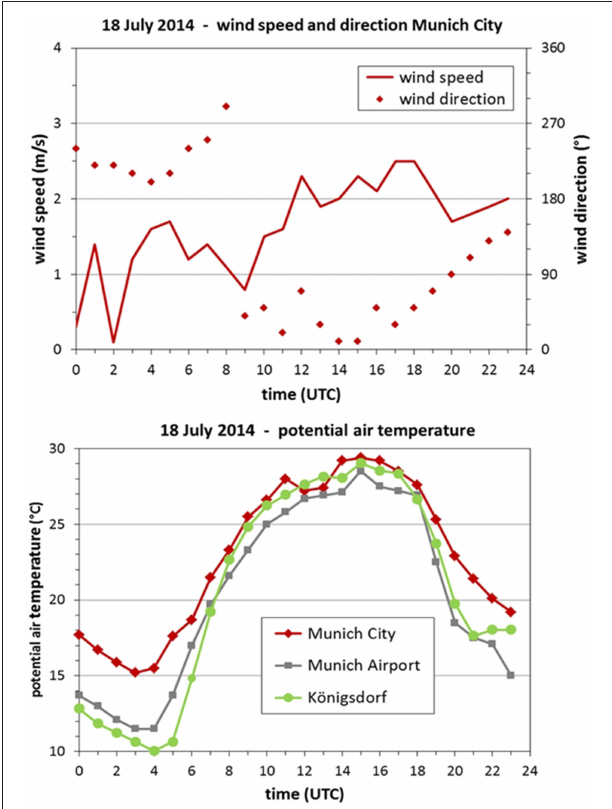
FIGURE 2 | Surface station data measured on 18 July 2014. Wind speed and direction above roof level at the station Munich City located northwest of the historic downtown area (top) and potential air temperature 2m above ground level at Munich City and at the two rural stations Munich Airport and Königsdorf (bottom). The station locations are shown in Figure 3